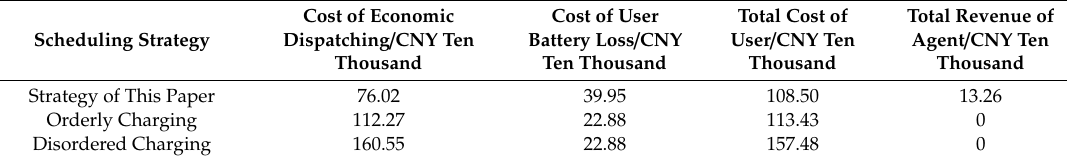
Table 5. Optimal interests of each market